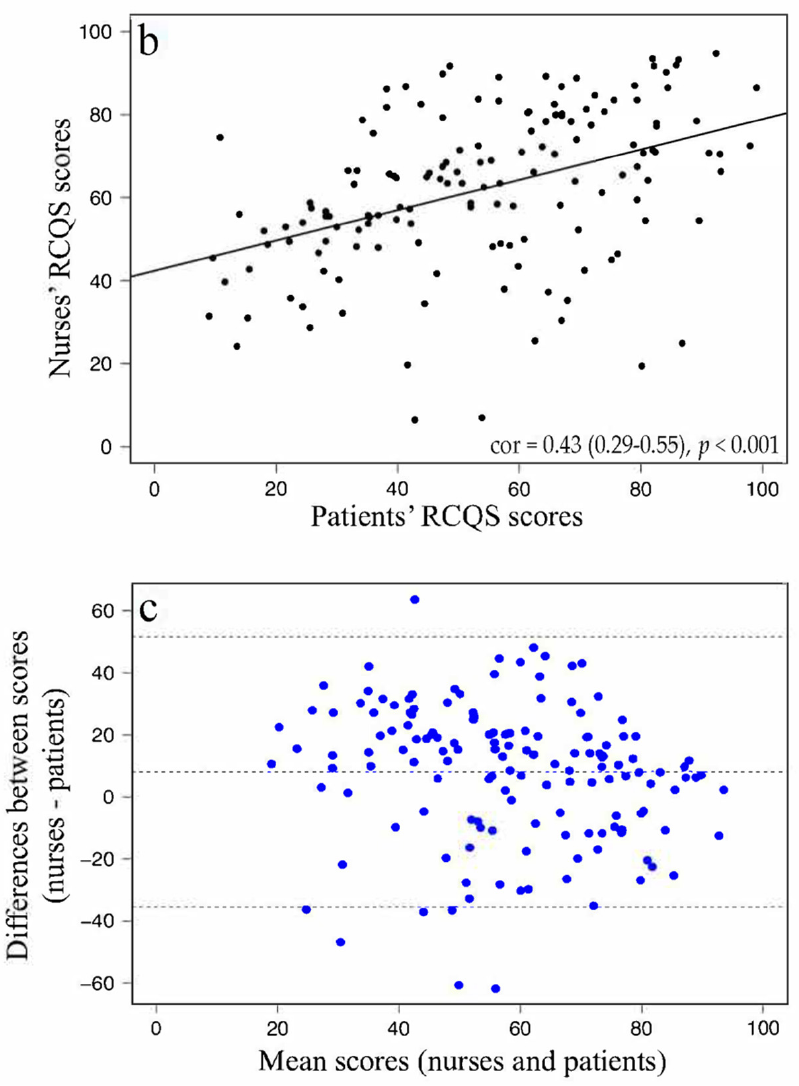
Figure 2. ( a ) RCSQ and mean sound levels at night; ( b , c ) nurses’ perception of patients’ sleep com- pared to the patients’